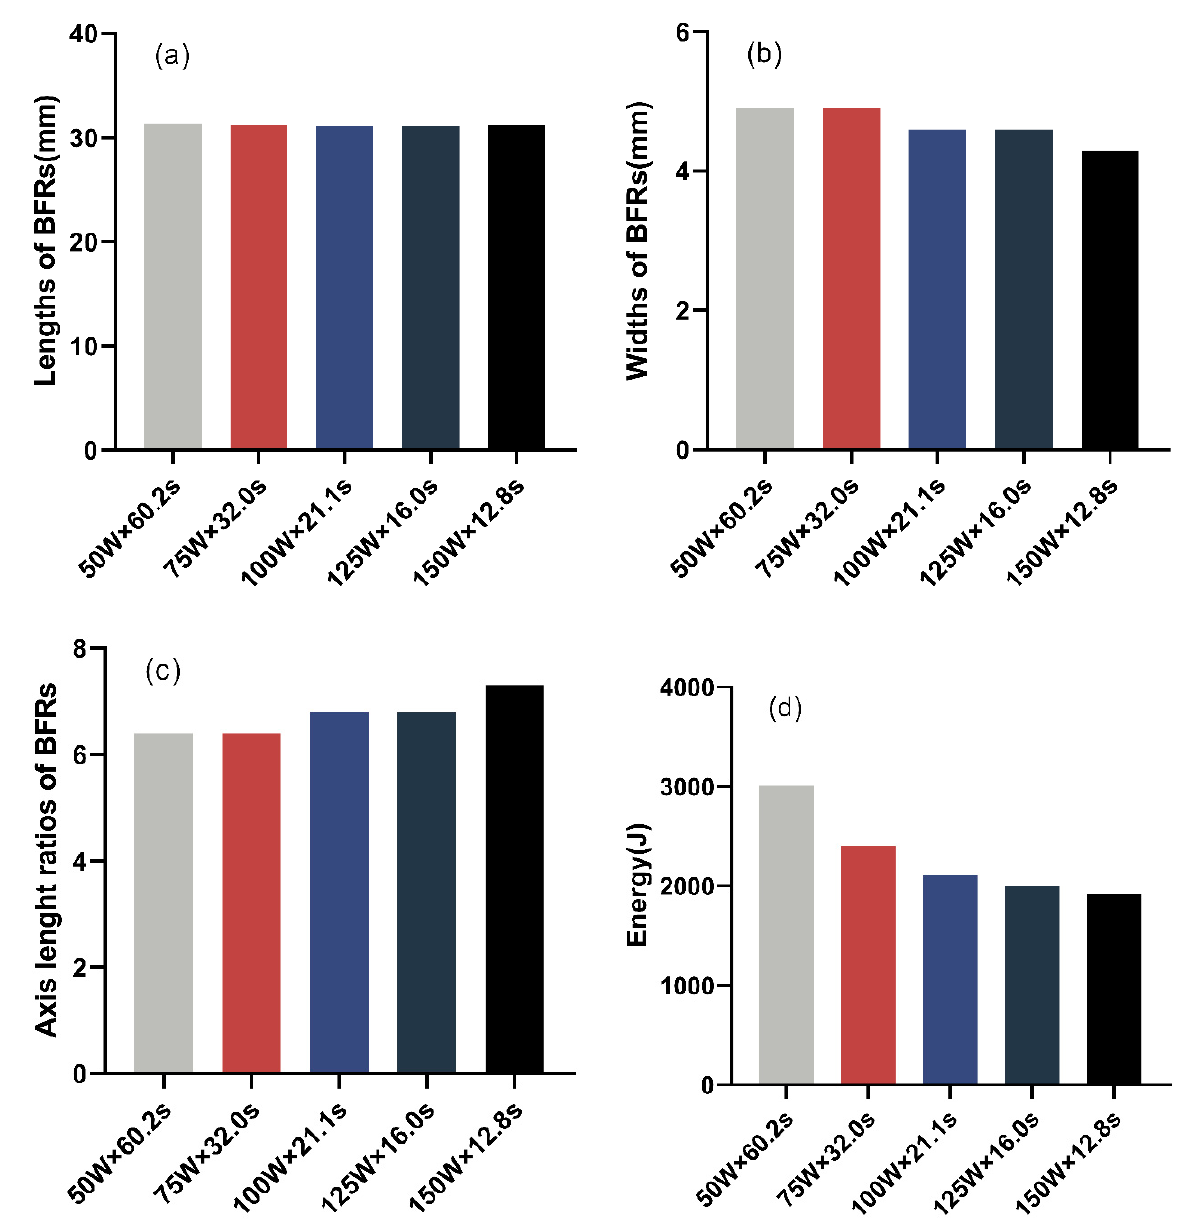
Figure 7. ( a ) Lengths ( b ) widths ( c ) axis length ratios of the BFRs, and ( d ) energy after ultrasonication with different combinations of acoustic power and time in bovine liver